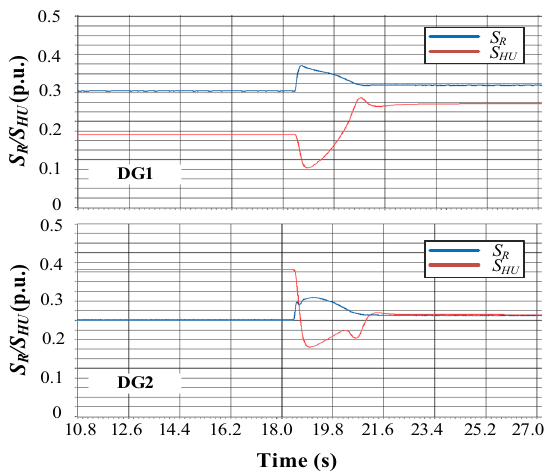
Fig. 23 Variation in the remaining capacity and the sum of the unbalanced and harmonic power of the DGs